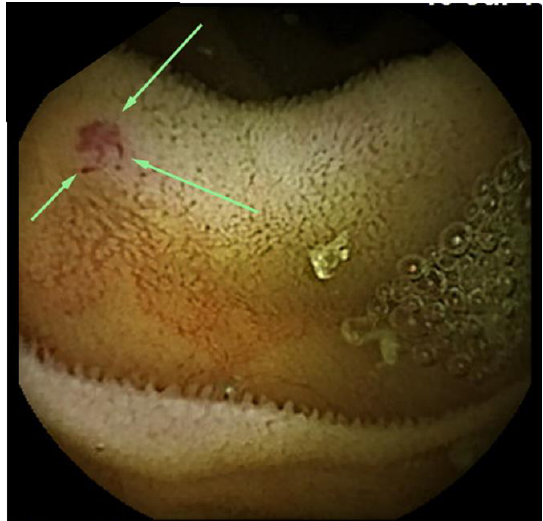
Figure 1. Small bowel capsule endoscopy findings at first examination. A 2-mm angioectasia (arrows) is apparent in the proximal small intestine, with no bleeding source identified.